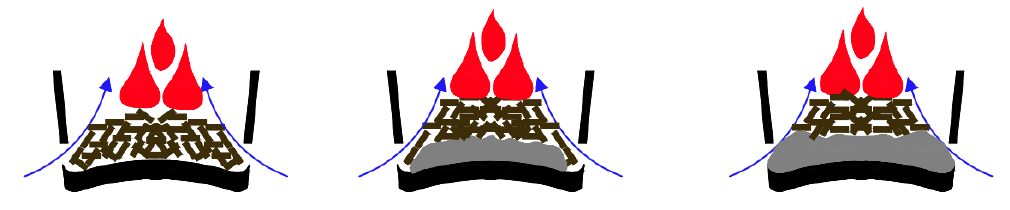
Figure 5. Sketch of combustion evolution in the “new” burner pot